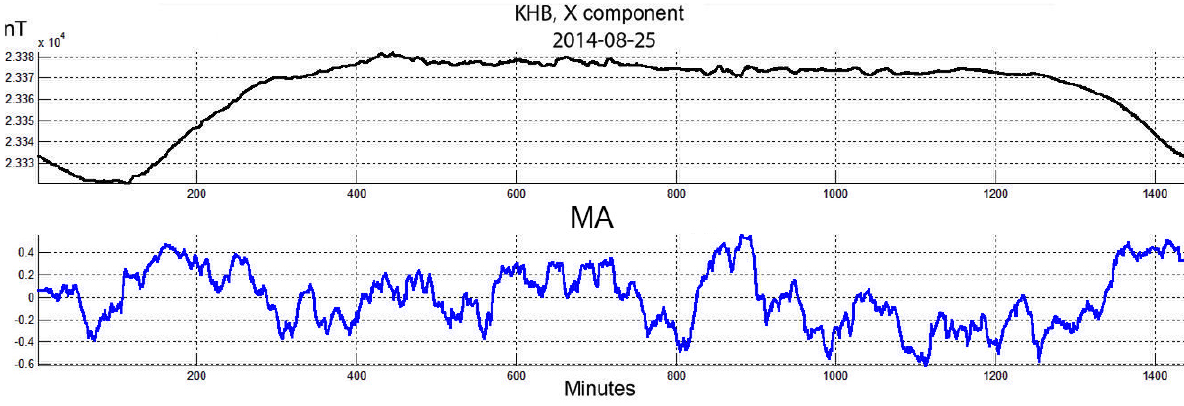
Figure 5. Activity estimation using MA in X component, recorded at Khabarovsk observatory (upper plot) on August 25, 2014 (lower